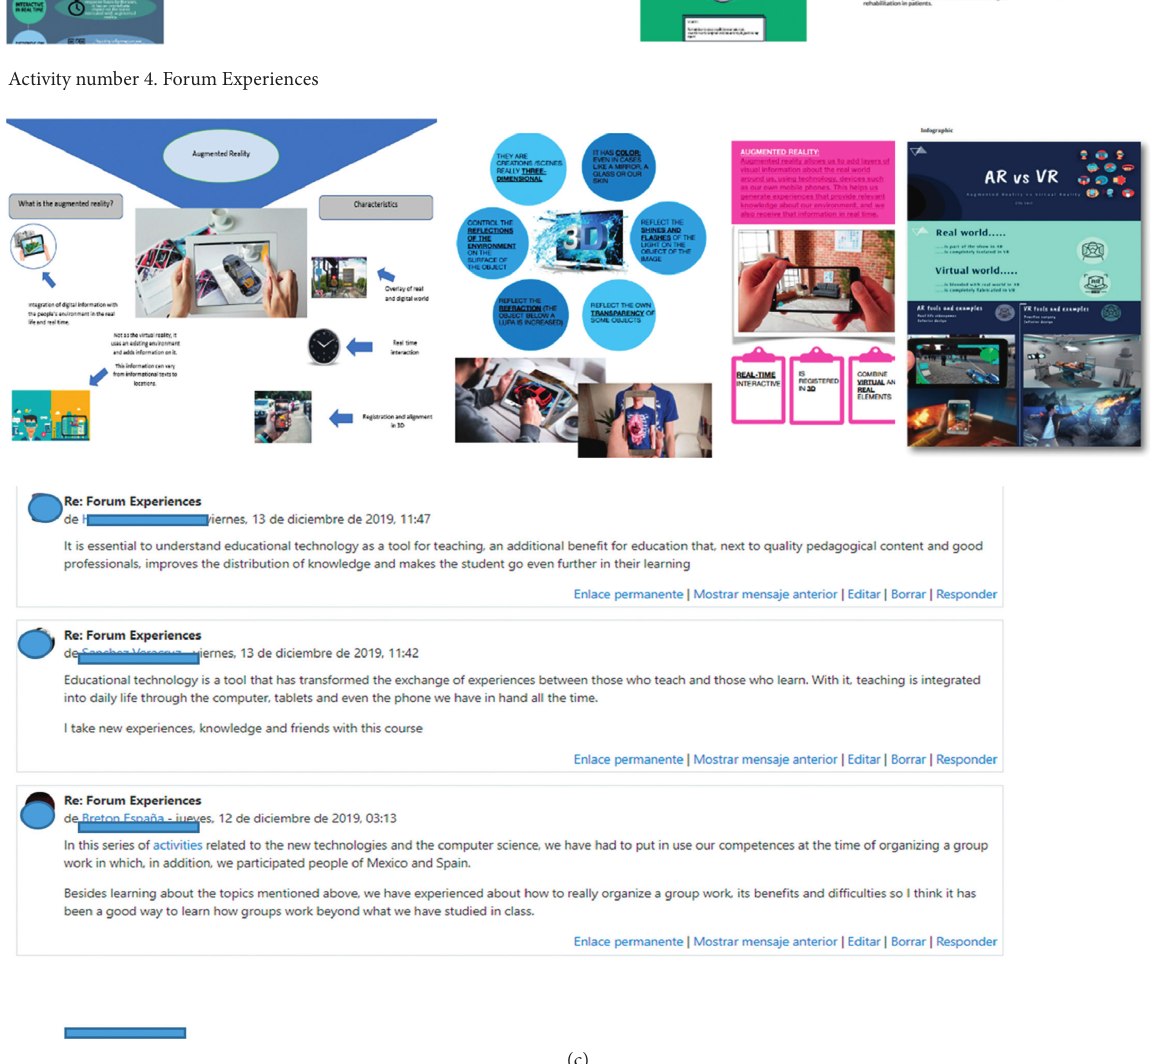
Figure 1: Screenshots from the Moodle platform and the activities of the